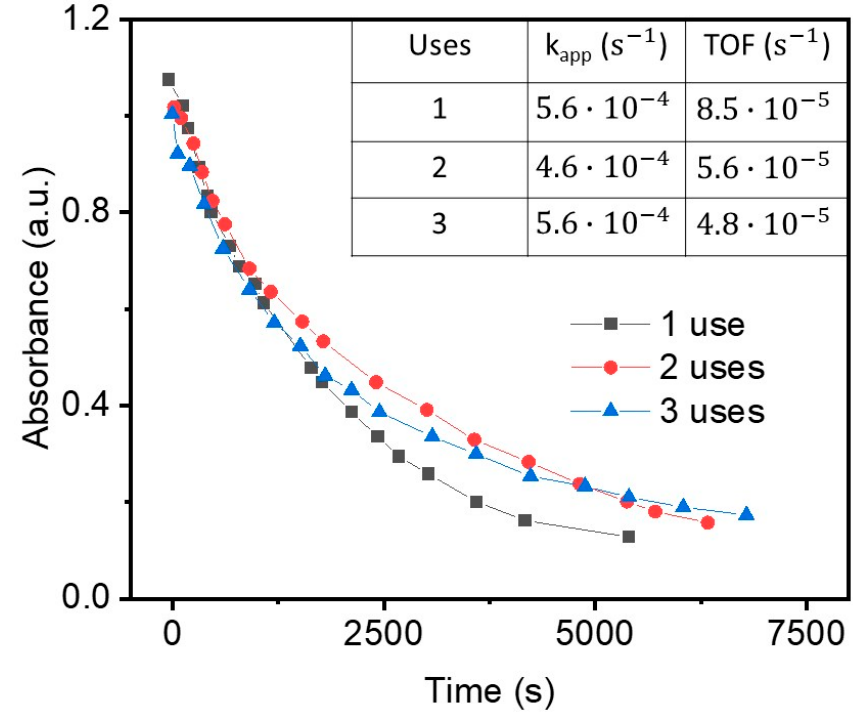
Figure 4. Kinetic trace of the absorbance at 400 nm during the reduction of p-NP in the presence of the same PDMS sponge doped with Pd NPs for different recycle numbers, as indicated. [p-NP] = 5 × 10 − 5 M, [NaBH 4 ] = 0.1 M and pH = 13. The solid lines show the best fit of Equation (1) to experimental data. The inset shows the k app and the TOFs values calculated to each use.